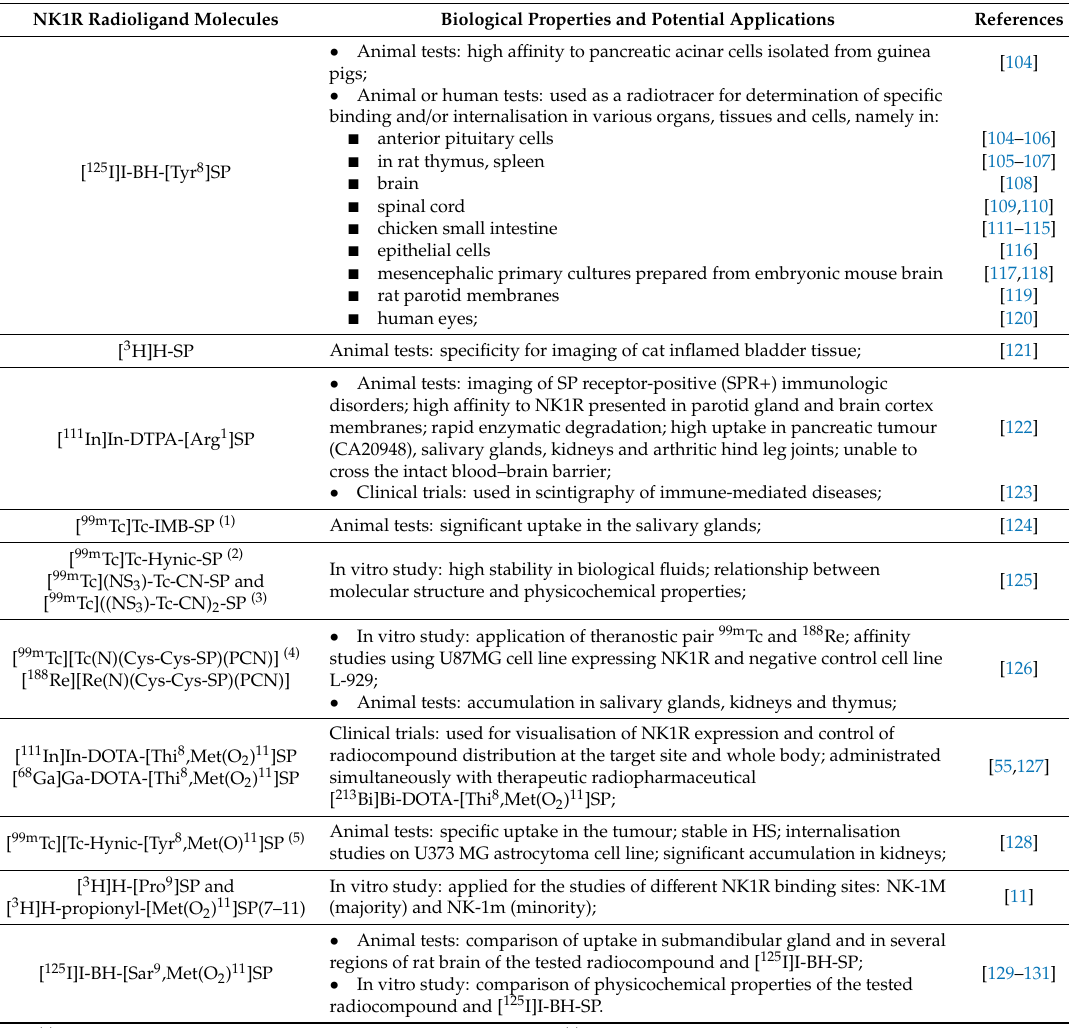
Table 4. Structure and potential application of NK1R diagnostic radioligands based on SP and its analogues or